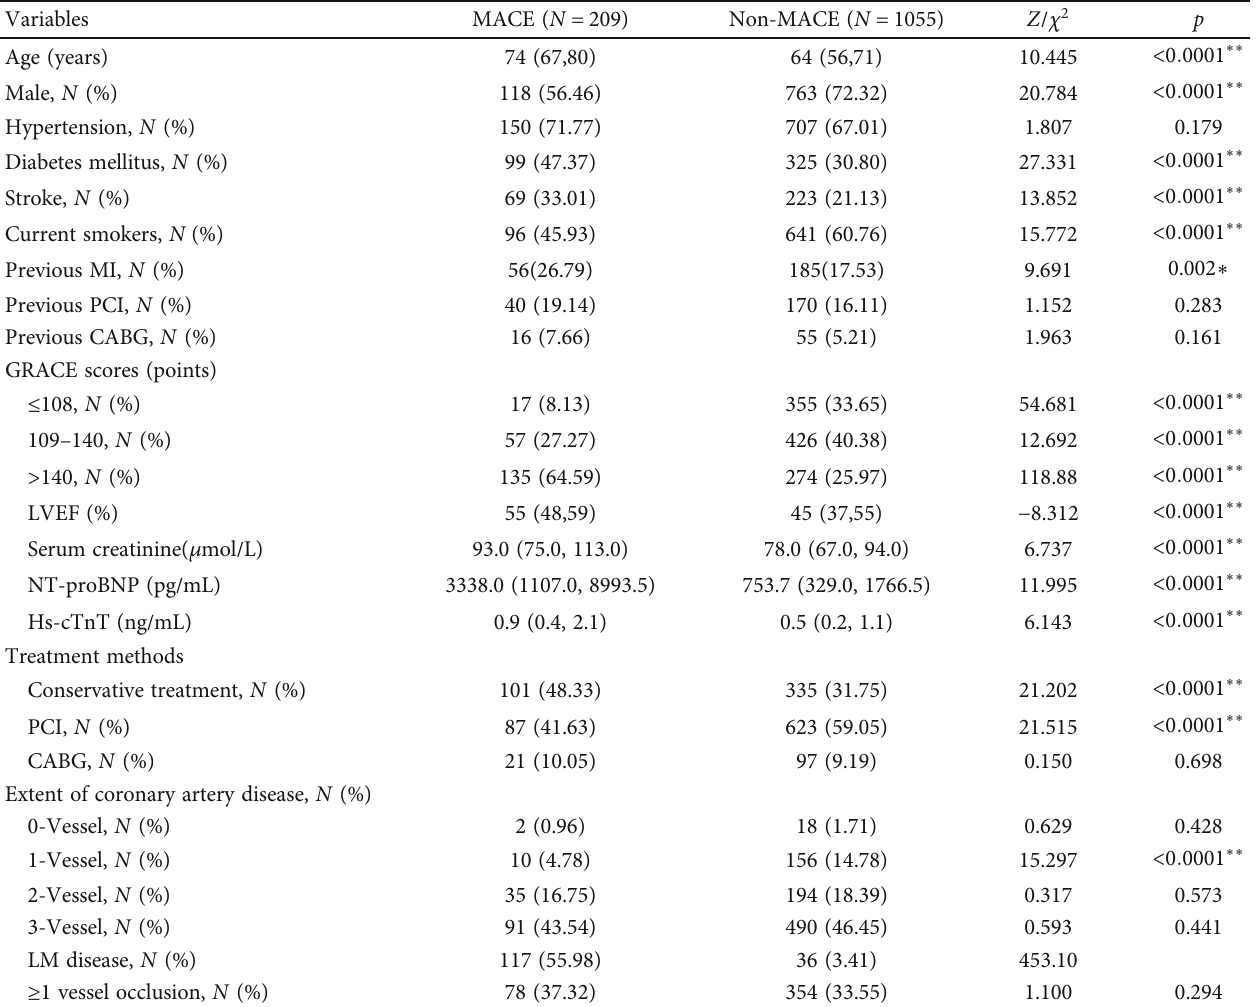
Table 2: Comparison of general admissions of patients in the MACE group and non-MACE